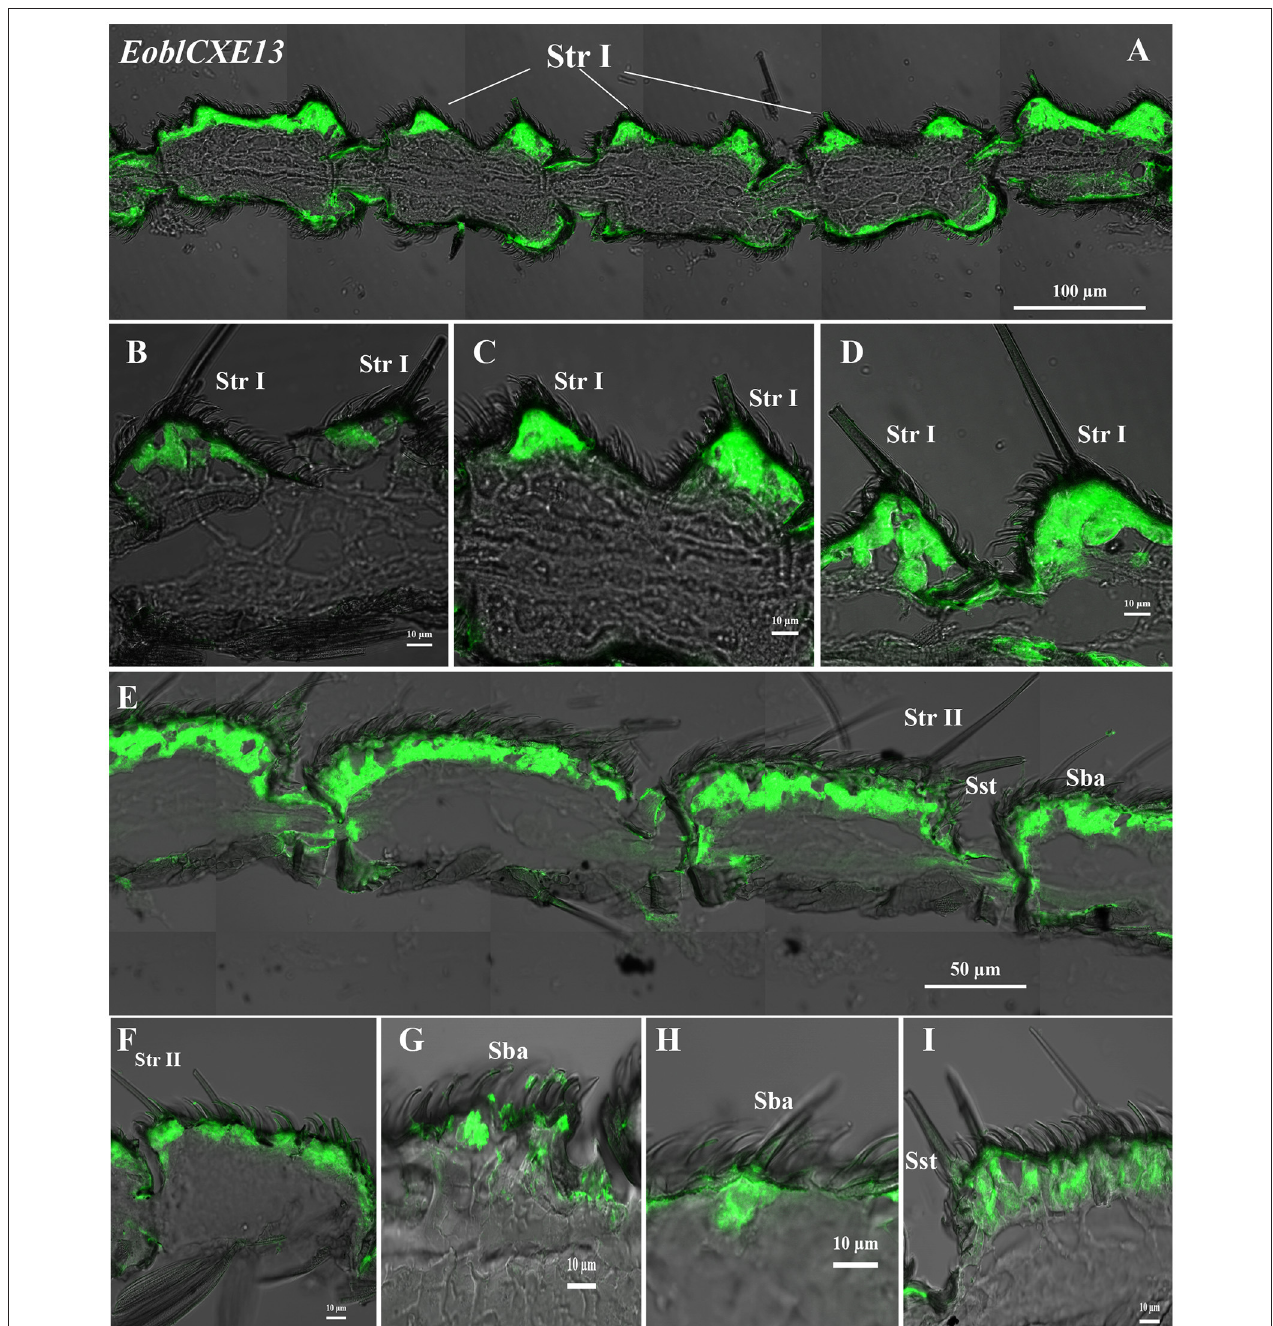
FIGURE 5 | Localization of the EoblCXE13 gene in different antennal sensilla of both sexes, as revealed via fluorescence in situ hybridization. (A–D) male antennae; (E–I) female antennae; Str I, sensilla trichodea I; Str II, sensilla trichodea II; Sba, sensilla basiconica; Sst, sensilla styloconica.